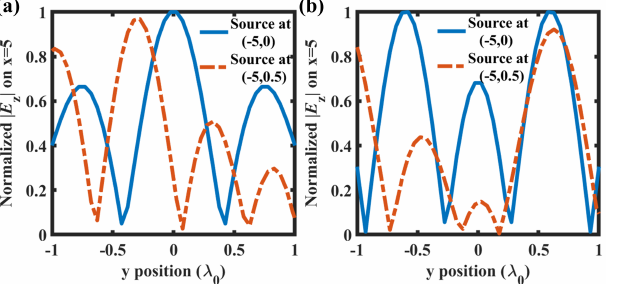
Figure 8. Normalized | E z | at the receiving line (at x = 5) excited by the two point sources at the positions ( − 5, 0) and ( − 5, 0.5): ( a ) S c = 7 λ 0 ; ( b ) S c = 5 λ 0